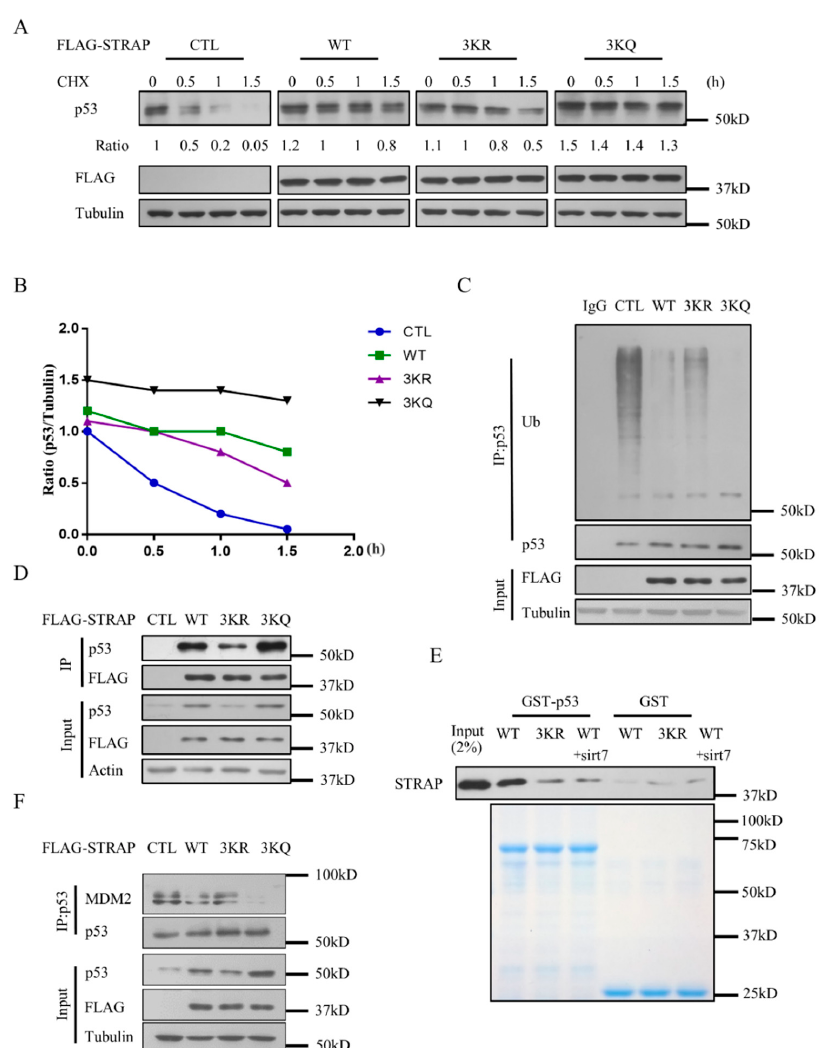
Figure 5. Modulation of p53 stability by STRAP acetylation. ( A ) Measurement of p53 stability by Western blotting with an anti-p53 antibody. HCT116 cells were transiently transfected with pcDNA3.1-Flag empty vector (Vector), STRAP-WT (WT), STRAP-3KR (3KR), or STRAP-3KQ (3KQ) for 24 h. Time intervals indicate the number of hours after cycloheximide (CHX) treatment (100 µ g / mL). Whole-cell lysates were analyzed by Western blotting with indicated antibodies. ( B ) Line graph indicating the measured p53 levels under each condition determined by scanning the p53 bands. ( C ) Determination of p53 ubiquitination. HCT116 cells were transfected with pcDNA3.1-Flag empty vector (Vector), STRAP-WT (WT), STRAP-3KR (3KR), or STRAP-3KQ (3KQ), as indicated, together with HA-tagged ubiquitin (Ub). Whole-cell lysates were immune-precipitated with control IgG, anti-p53 antibody, and precipitated proteins were detected by an anti-HA antibody to determine the level of p53 ubiquitination. ( D ) STRAP interacts with p53 in vivo. HCT116 cells were transfected with pcDNA3.1-Flag empty vector (Vector), STRAP-WT (WT), STRAP-3KR (3KR), or STRAP-3KQ (3KQ) for 24 h. Whole-cell lysates were immune-precipitated with M2 beads and analyzed by Western blotting with indicated antibodies. ( E ) STRAP interacts with p53 in vitro. Flag-STRAP (WT), Flag-STRAP